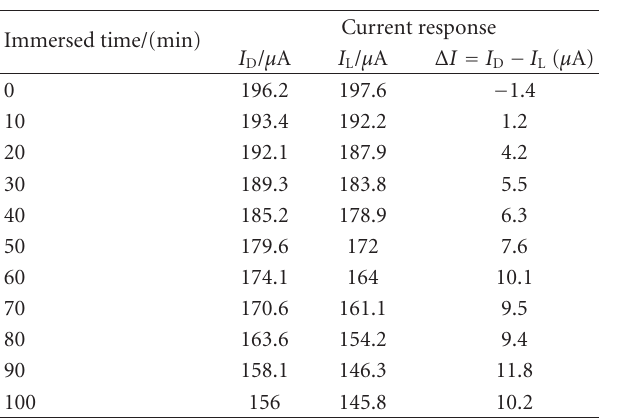
Table 1: The current peaks response of chiral interface exposed to L- and D-Trp for di ff erent time periods.